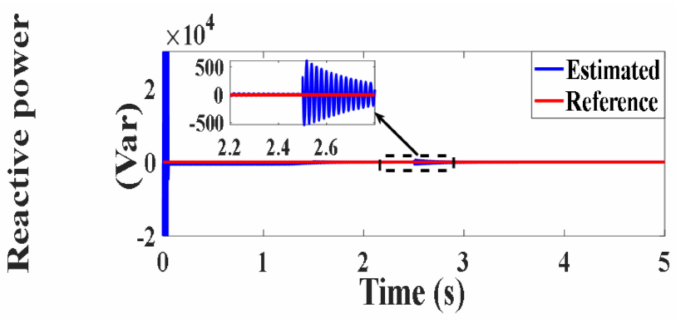
Figure 18. Reactive power under SVOC (var).